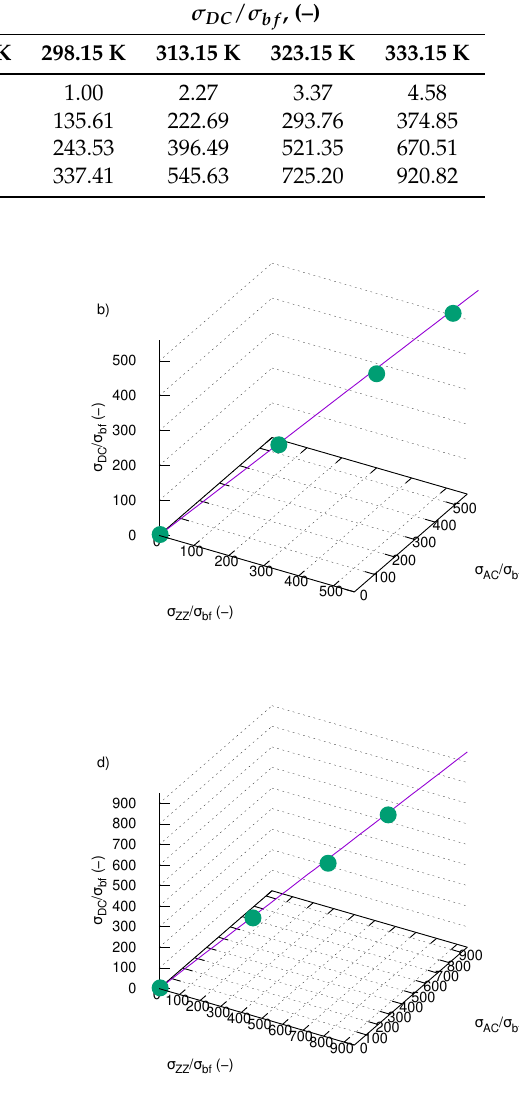
Figure 15. Comparison results of electrical conductivity enhancement obtained with three different methods for temperature: ( a ) 298.15 K, ( b ) 313.15 K, ( c ) 323.15 K, ( d ) 333.15 K; σ DC / σ bf —electrical